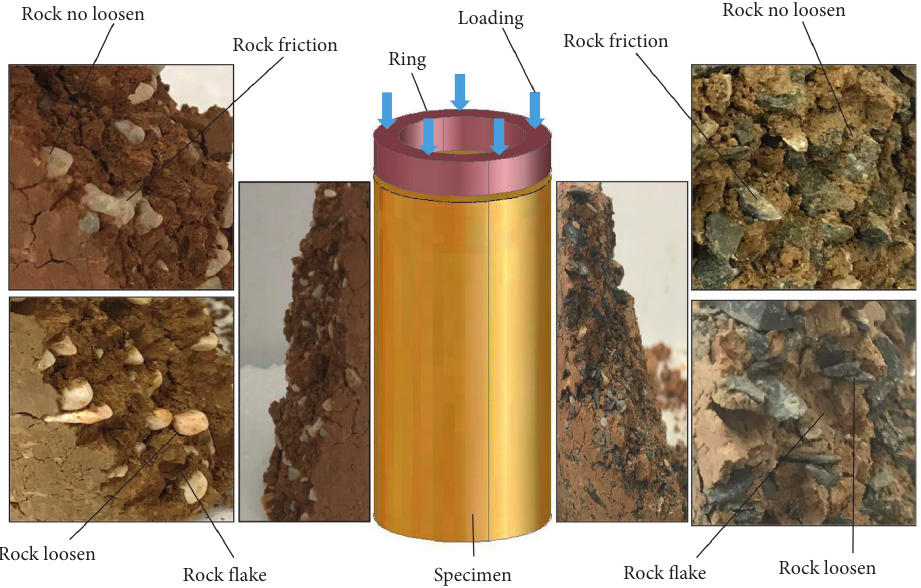
Figure 14: Failure surfaces of test specimens under ring